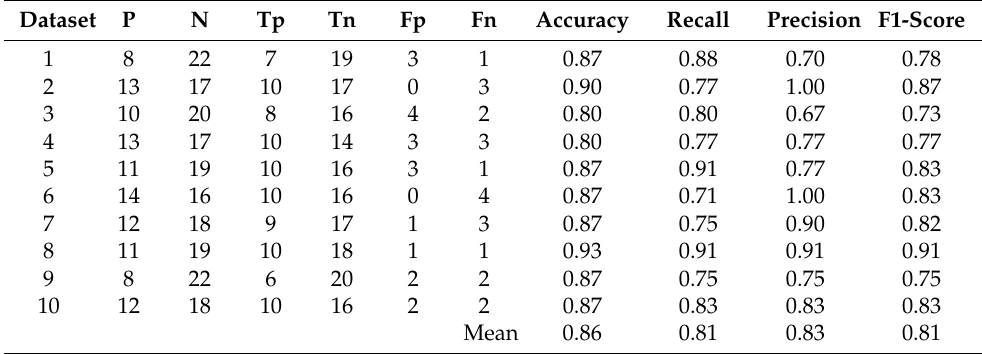
Table 4. R.F. models trained and tested on ten randomly selected datasets.